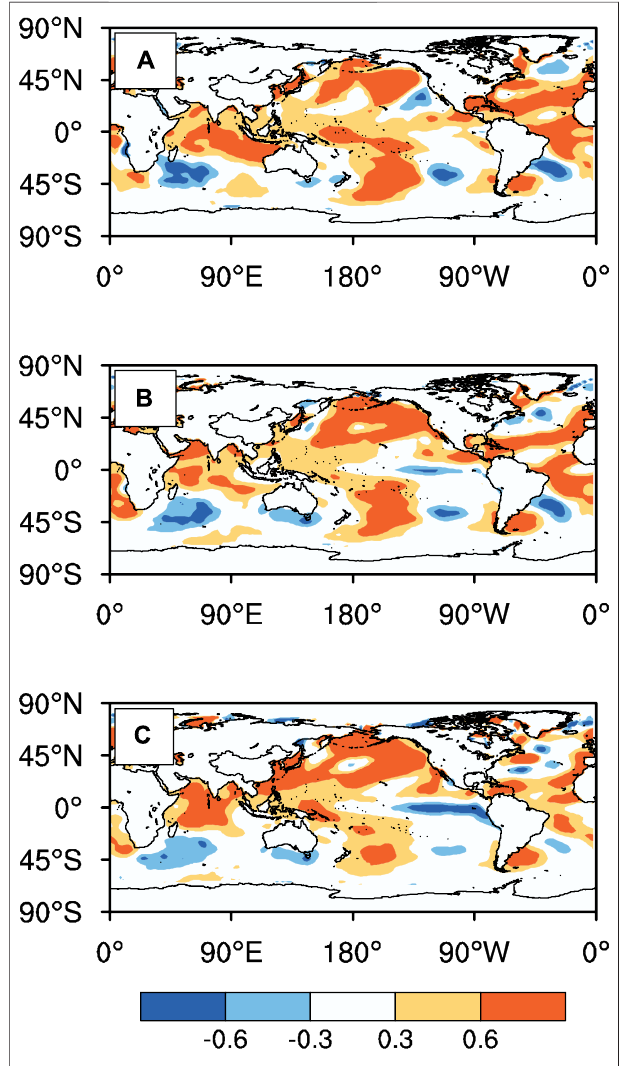
FIGURE9| DistributionofSSTAfromApriltoJunein2020(shaded,unit: ° C). In (A) April, (B) May, and (C) June.